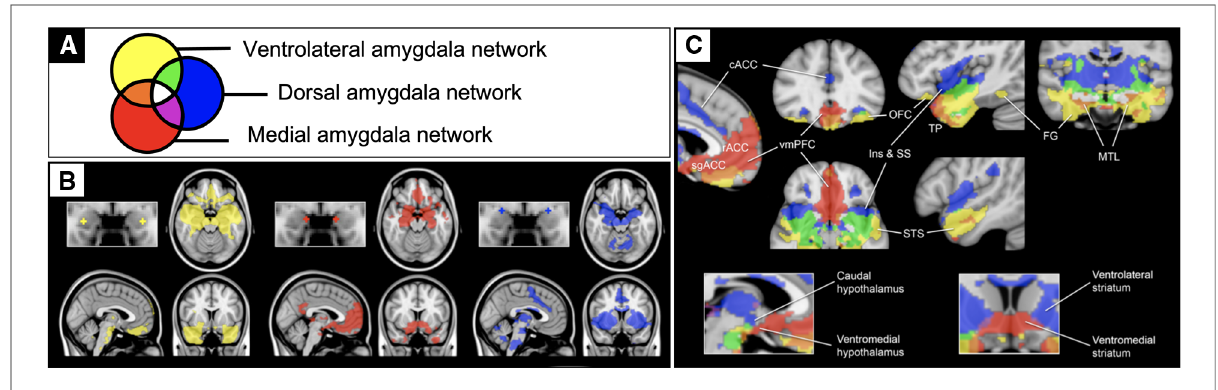
FIGURE 1 Previously published rsfMRI functional connectivity maps of the amygdala. Previously published one sample group mean signi fi cance maps color coded ( A ) for each of 3 amygdala seeds ( N =89) displayed in standard views ( B ) and selected views for network differentiation ( C ). The maps are binarized at p <10 − 5 and overlaid on a T1 MNI152 0.5mm template brain in radiologic convention to demonstrate the distinct and shared connectivity across maps (38).